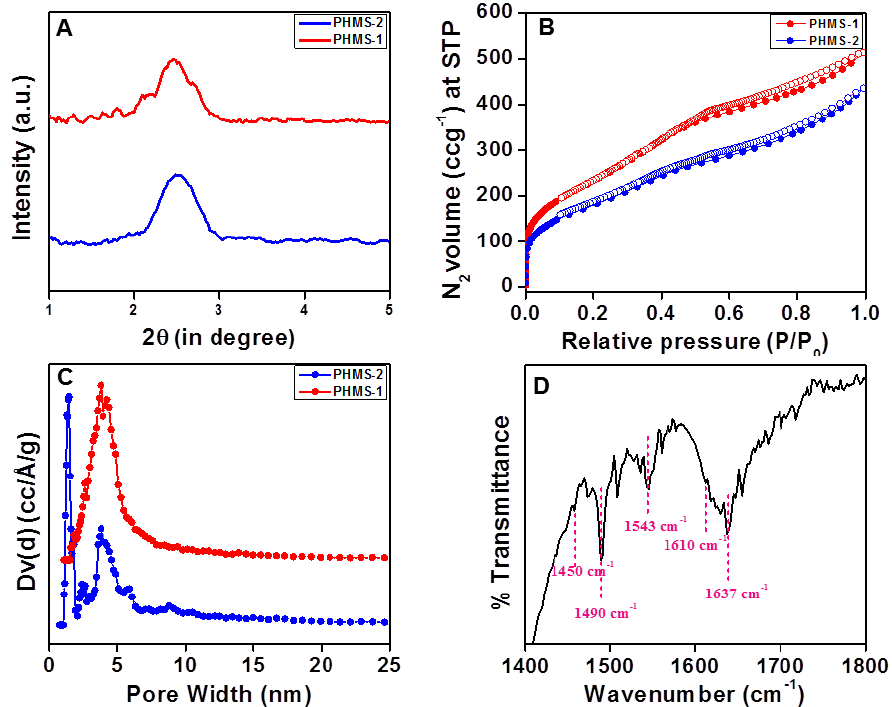
Figure 1. ( A ) Small-angle powder XRD pattern of PHMS-1 (red) and PHMS-2 (blue). ( B ) Nitrogen adsorption/desorption isotherms of PHMS-1 (red) and PHMS-2 (blue). ( C ) Non-local density functional theory pore-size distributions (PSD) of PHMS-1 (red) and PHMS-2 (blue). ( D ) Pyridine adsorbed FT-IR of PHMS-2.